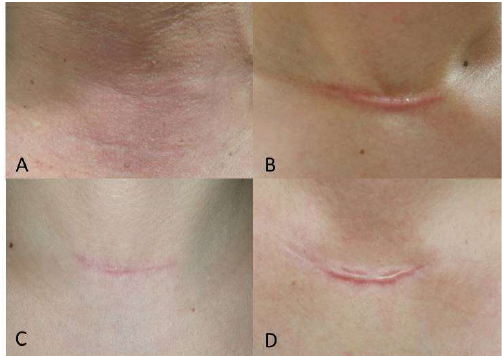
Figure 3. Representative postoperative scars at 24 weeks after open thyroidectomy; ( A ) A 54-year-old male in the Botox group; ( B ) a 41-year-old female in the control group; ( C ) a 46-year-old female in the Botox group; and ( D ) 54-year-old female in the control group.